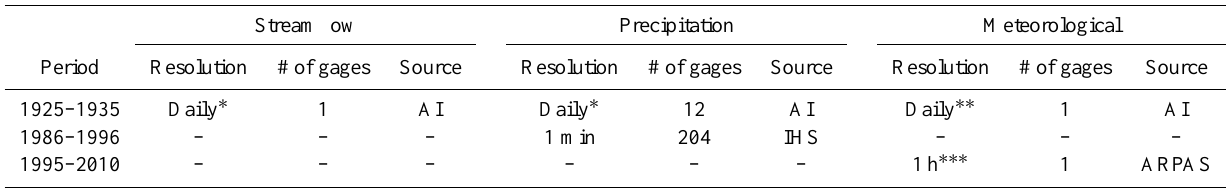
Table 3. Hydrometeorological data used in the study, including the resolution, the number of gages and the source for each type of data and available period. The sources include the following: AI, “Annali Idrologici”; IHS, Italian Hydrologic Survey (data provided by the branch in Sardinia); and ARPAS, the Sardinian Agency for Environmental Protection.